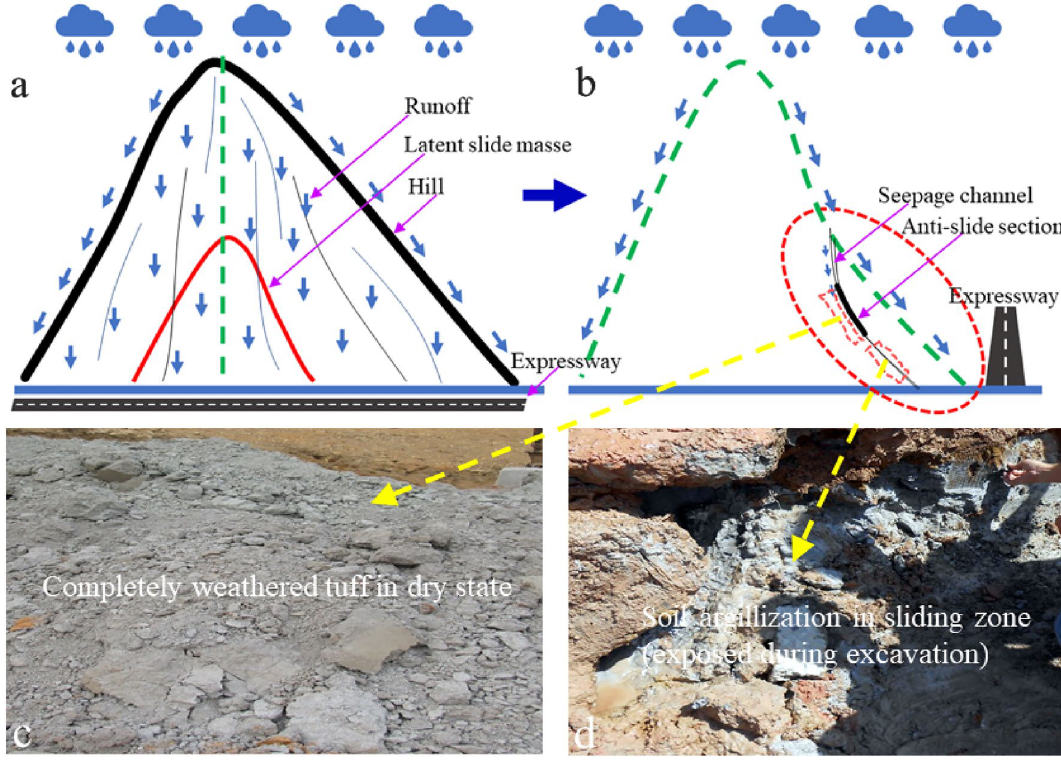
Figure 19. Occurrence mechanism of slope sliding caused by rainwater infiltration. ( a ) Schematic diagram of the sliding mass; ( b ) profile of the sliding mass (lateral view); ( c ) completely weathered tuff in natural dry state; ( d ) mudding state of the slip zone soil mixed by completely weathered tuff and silty